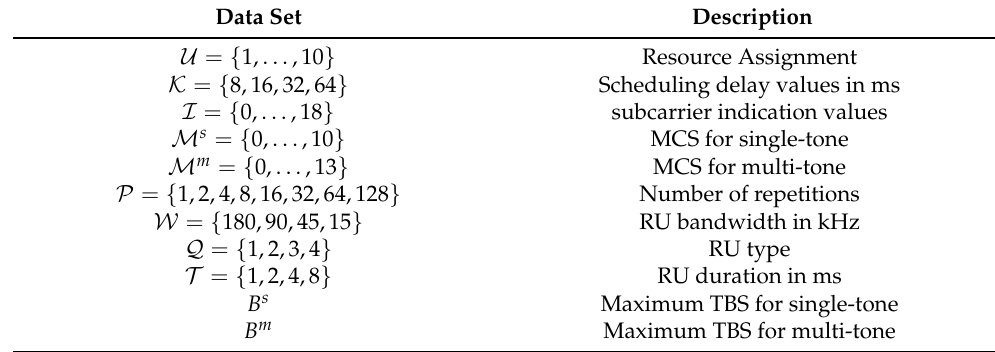
Table 11. Data set